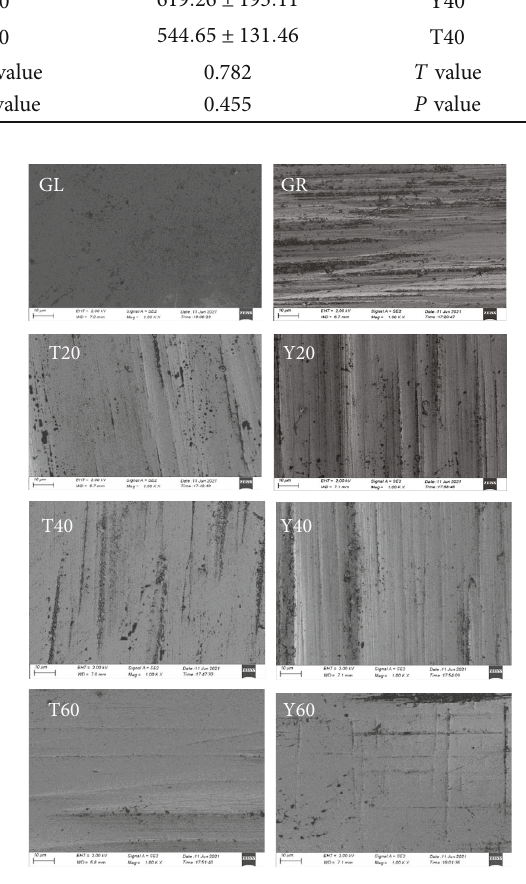
Figure 2: SEM observation for surface morphology of